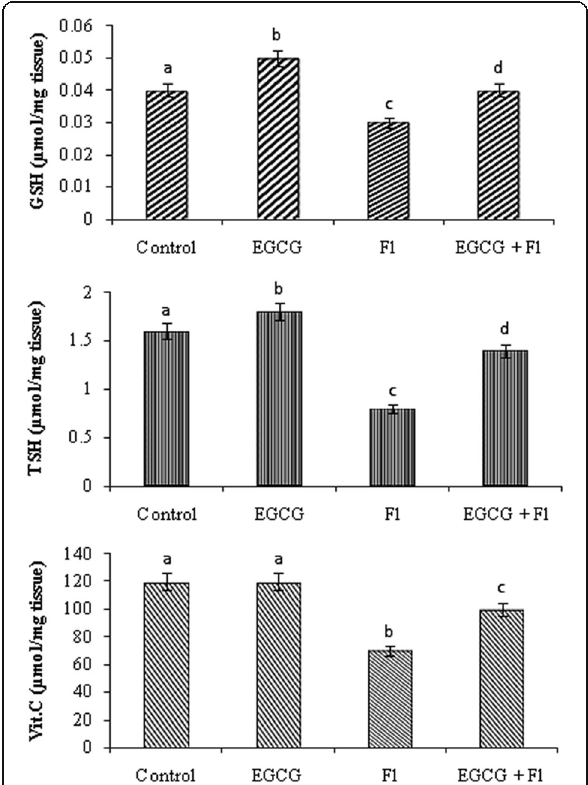
Fig. 5 Effect of EGCG on the non-enzymatic antioxidant (GSH, TSH, Vit.C) in the hippocampus of control and experimental rats. Values are mean ± SD for 6 rats in each group. a, b, c, d Values not sharing a common superscript letter (a, b, and c) differ significantly at p <0.05 (DMRT) Table 4 Effect of EGCG on enzymatic antioxidants SOD, CAT, GPx, GST, GR, and G6PD in the hippocampus of control and experimental rats Groups